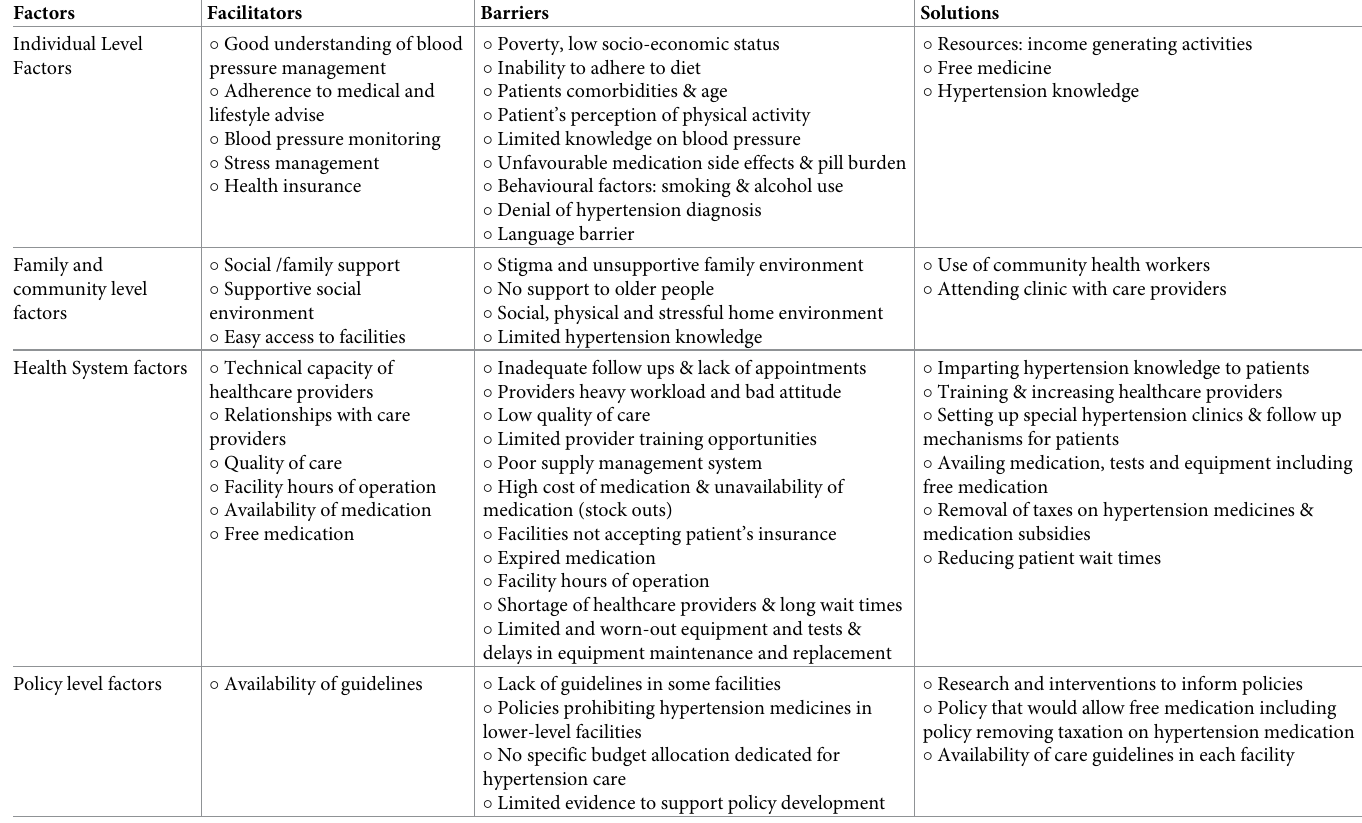
Table 2. Key themes and subthemes; facilitators, barriers and identified